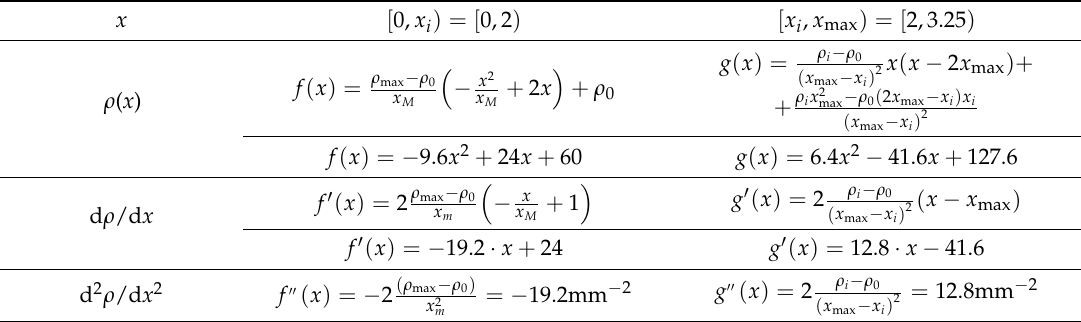
Table 2. Modeling of the reflection functions: Group N—dental pressed ceramics.